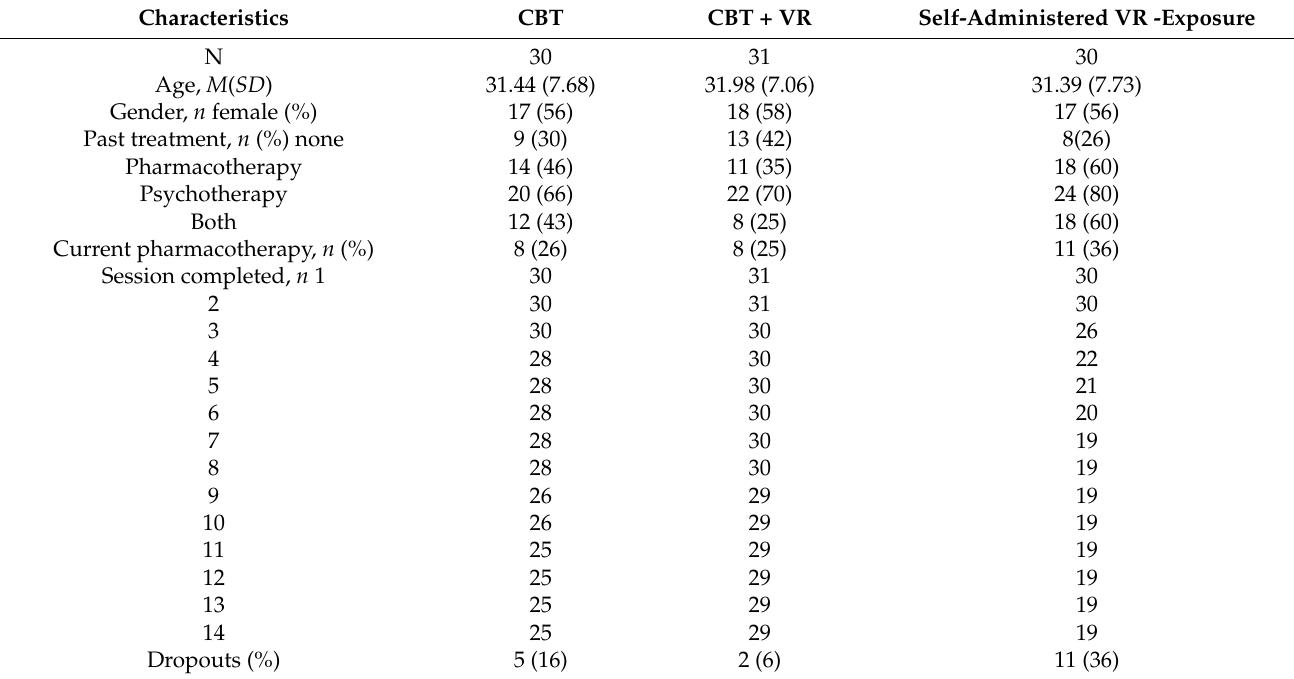
Table 1. Participant